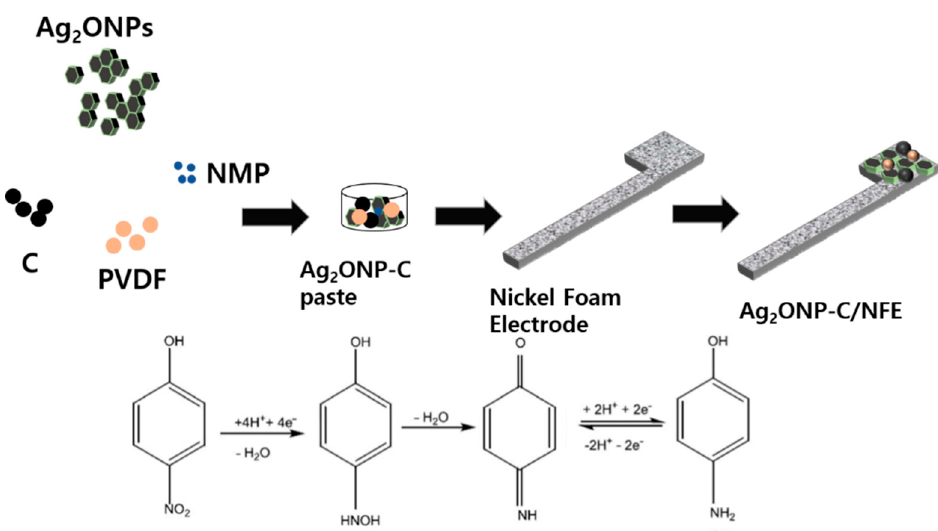
Figure 7. Schematic diagram of device fabrication and p -NP detection chemical route.